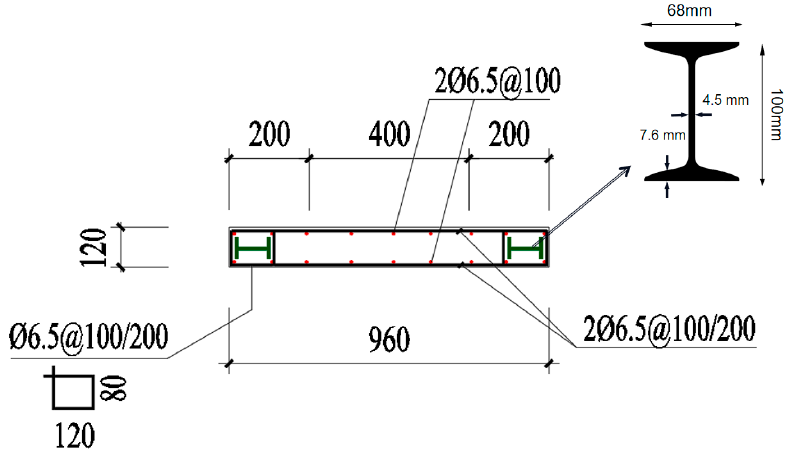
Figure 2. Plan view and the layout of the reinforcements of the shear wall specimens (unit: mm). ( Φ is the diameter of bars, @ is the center-to-center distance of bars).